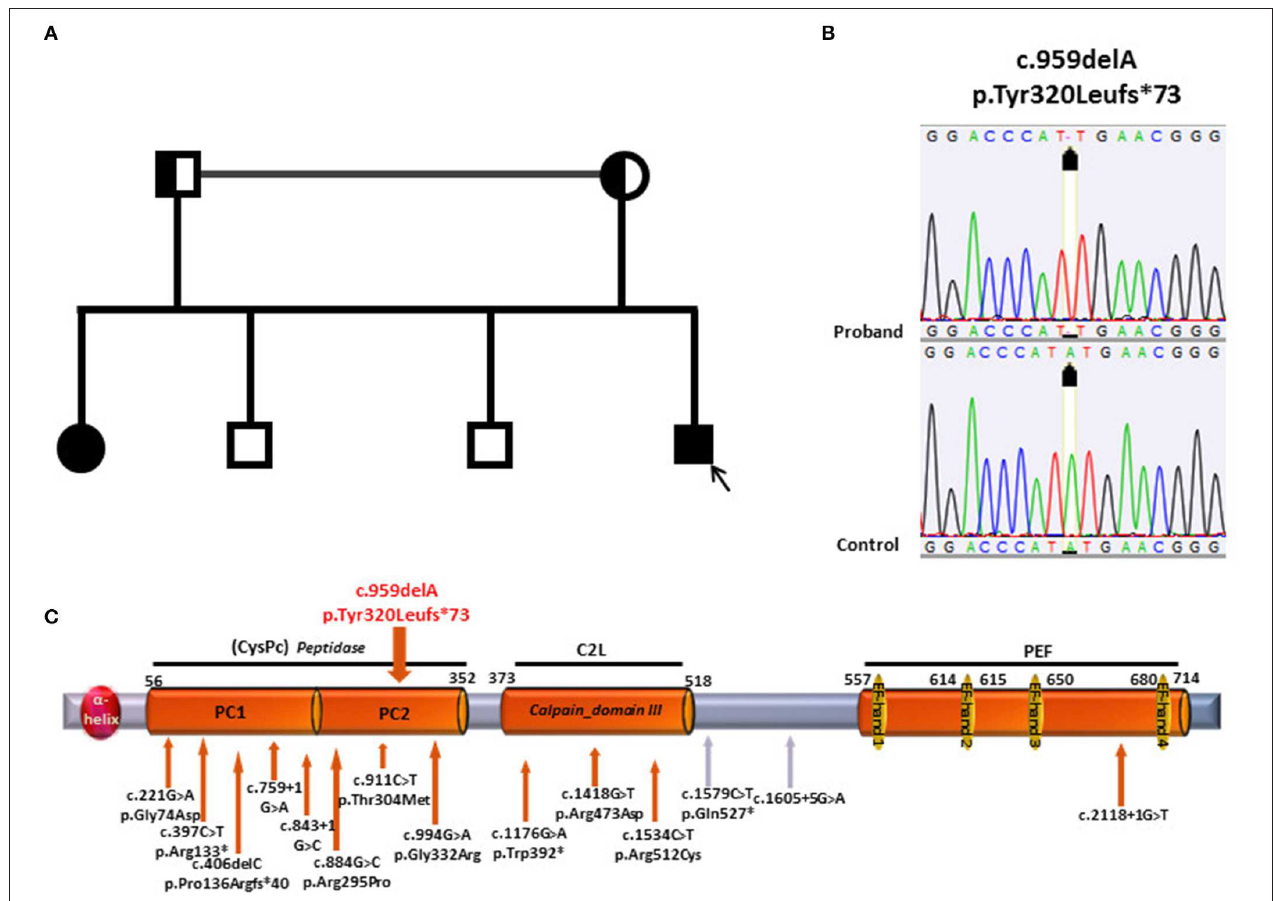
FIGURE 1 | (A) Pedigree of the family; the patient is depicted by a black arrow. (B) Electropherograms of CAPN1 sequence in patient and control. (C) Structure of CAPN1 protein, Calpain 1, its domains with location of the mutations previously identified (under the gray bar) and the mutation identified in the current study (on top of the gray bar). At the N-terminus of the protein, an a-helix domain is followed by two Protease core domain, 1 and 2 (PC1and PC2), constituting the Peptidase- Cystein Protease core Peptidase (CysPC); the Calpain domain III- also known as C2-like Ca 2 + − Binding domain (C2L) precedes the PEF (Penta EF-hand) domain at the C terminus containing 5 EF-hand